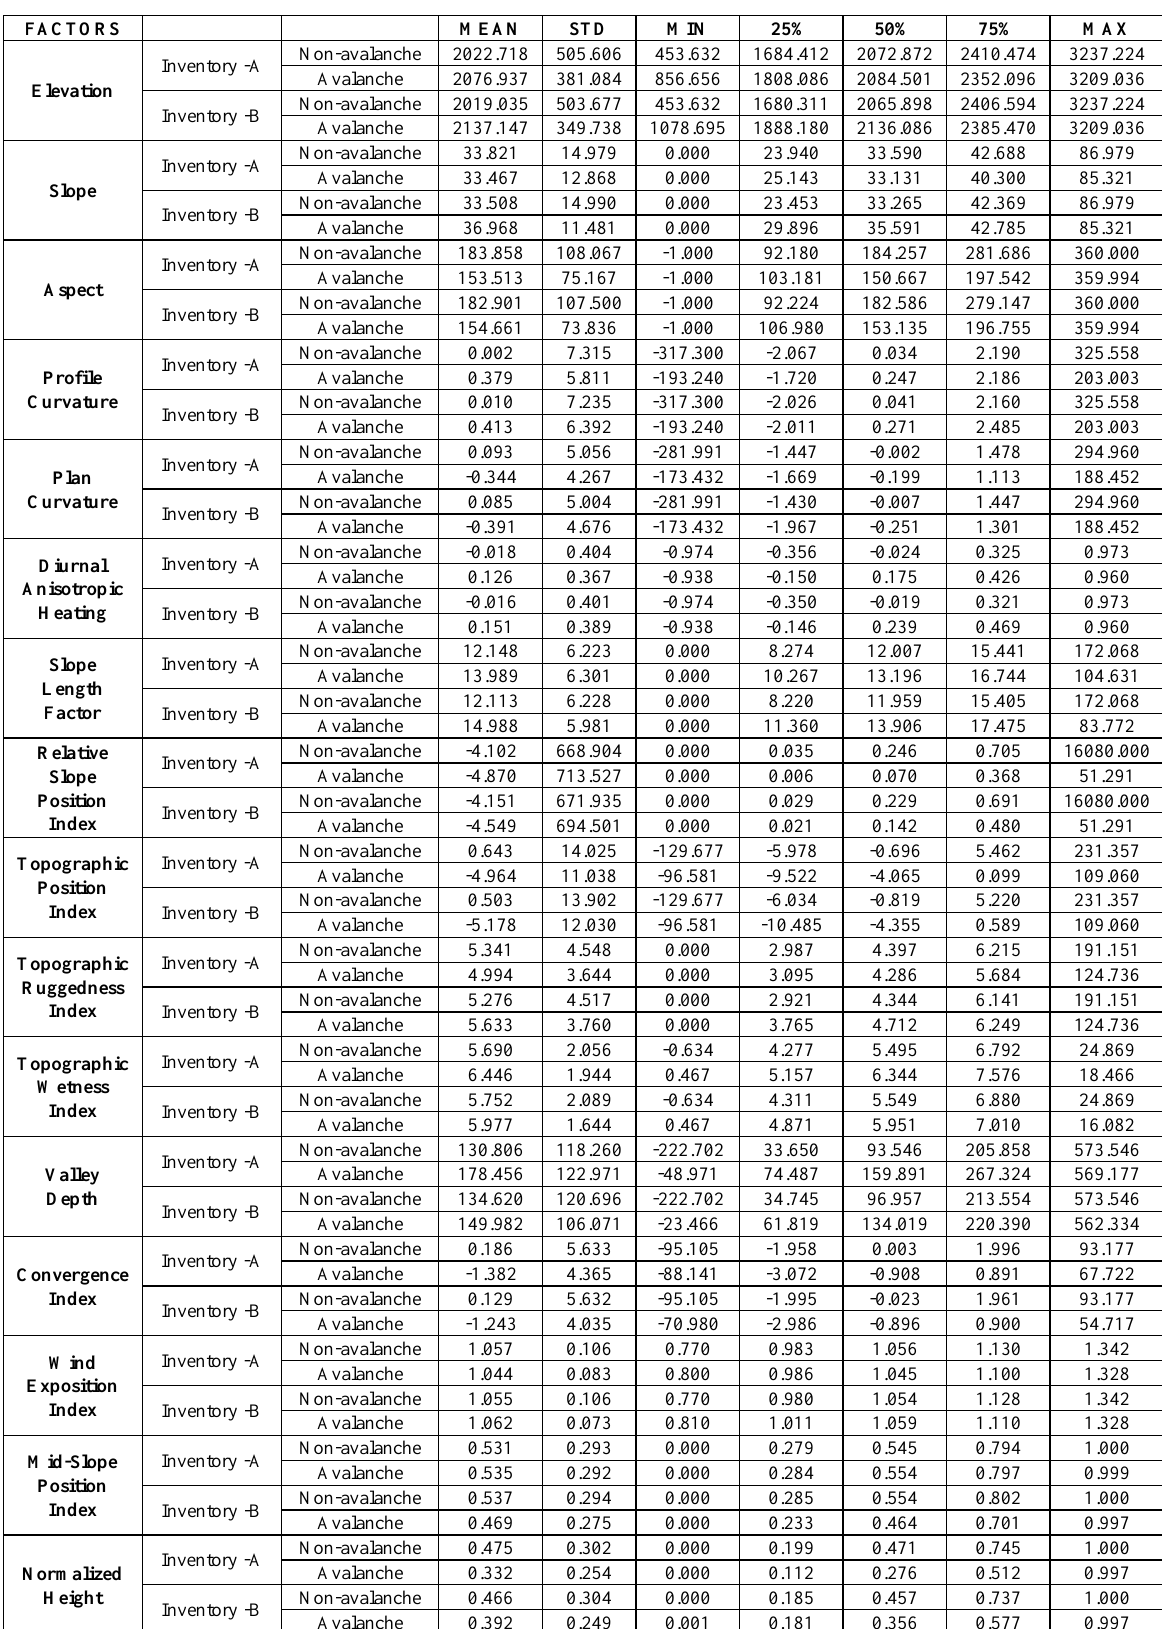
Table A1. Summary statistics of the numerical factors based on Inventory-A and